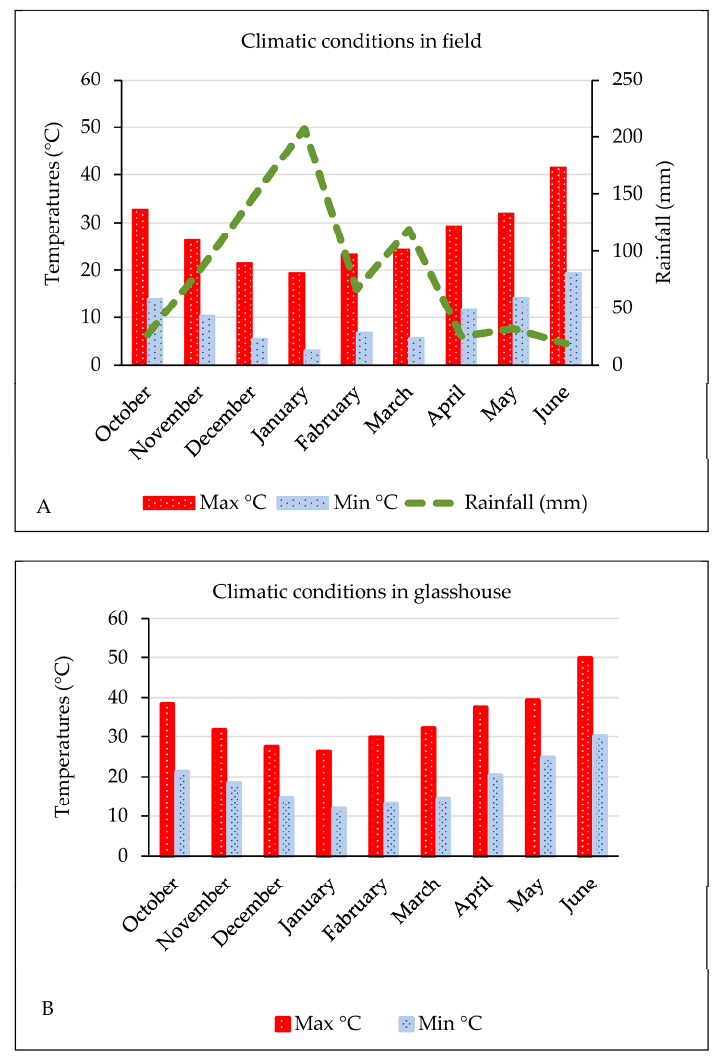
Figure 1. Long-term climatic conditions in field ( A ) and glasshouse ( B ) from 2016 to 2020.